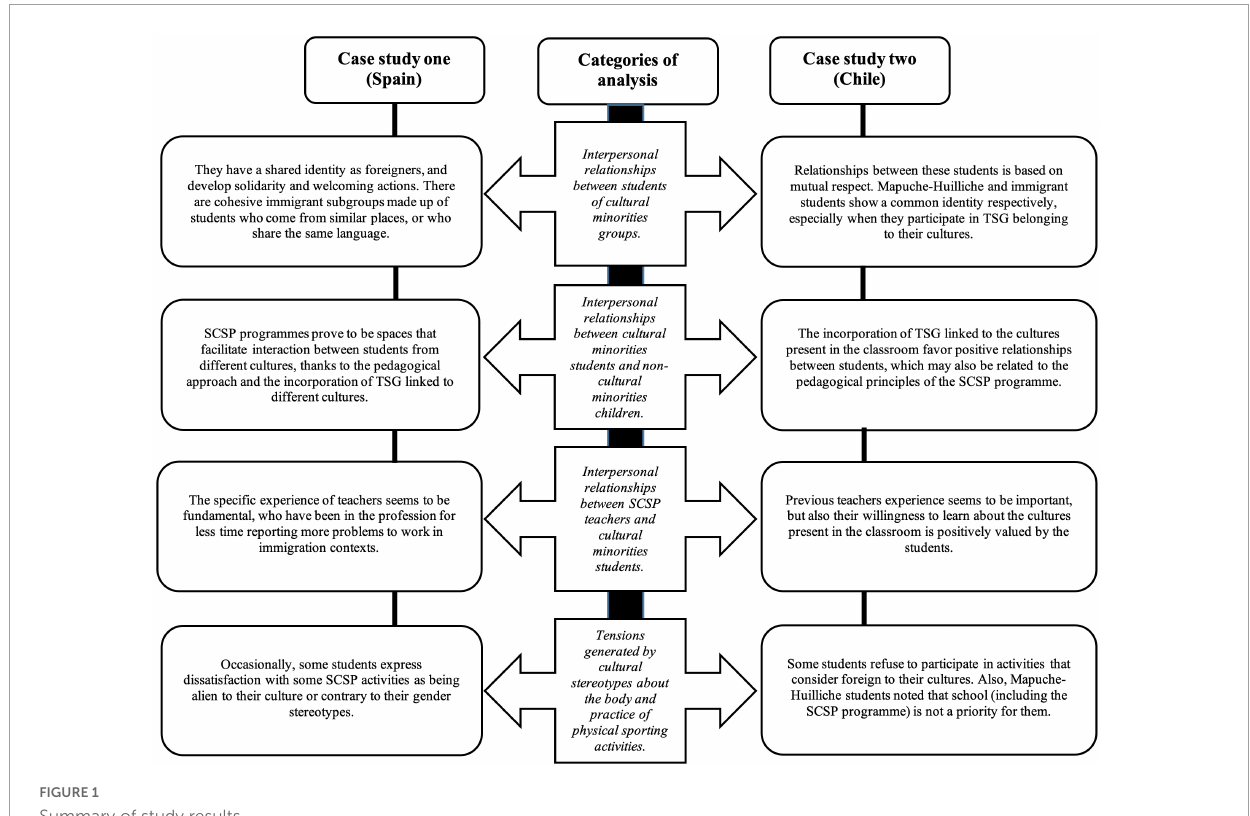
FIGURE1 Summary of study